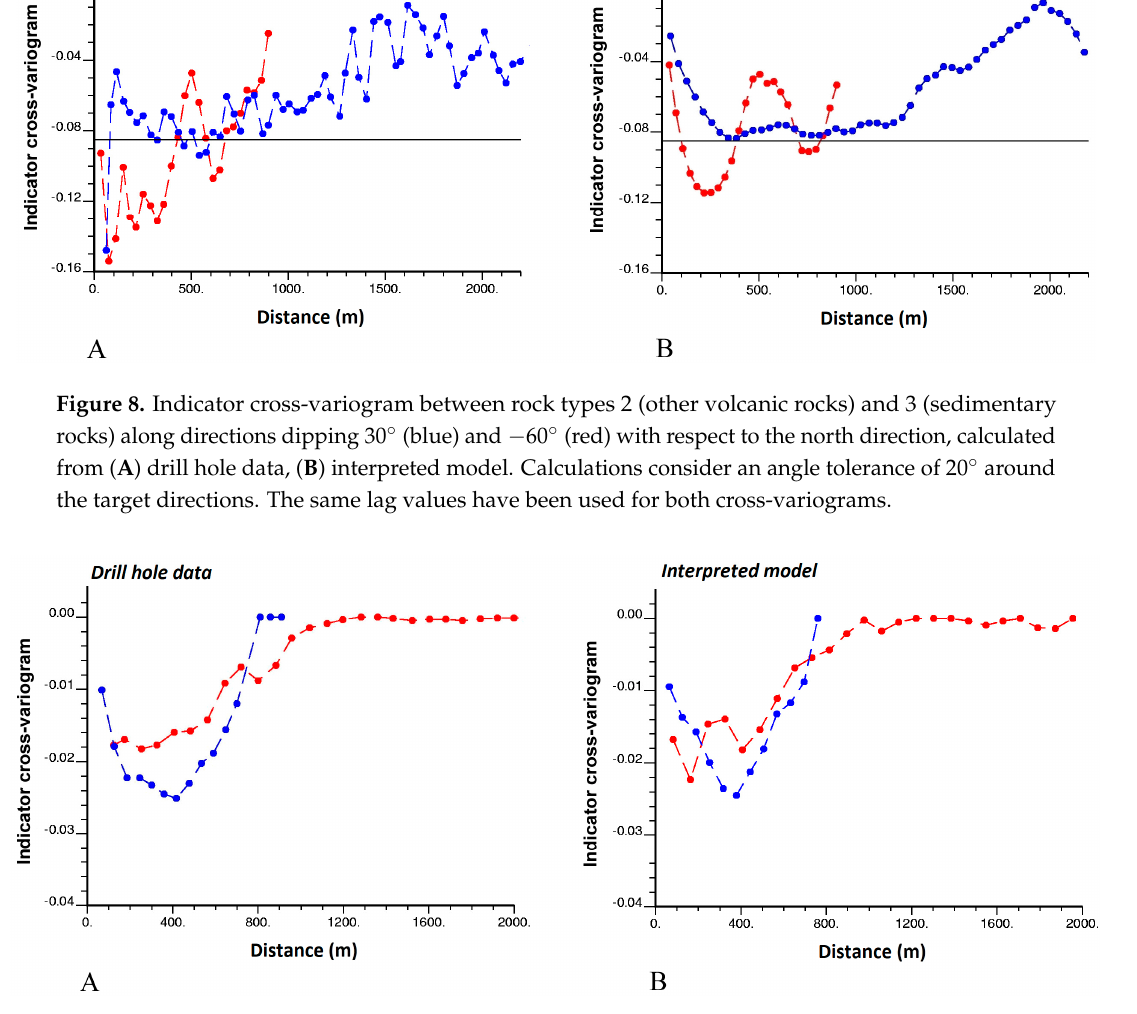
Figure 10. Indicator cross-variogram between rock types 4 (granodioritic porphyry) and 6 (hydrothermal breccia) along directions dipping 75° (blue) and − 15° (red) with respect to the north direction, calculated from ( A ) drill hole data, ( B ) interpreted model. Calculations consider an angle tolerance of 20° around the target directions. The same lag values have been used for both cross- variograms.